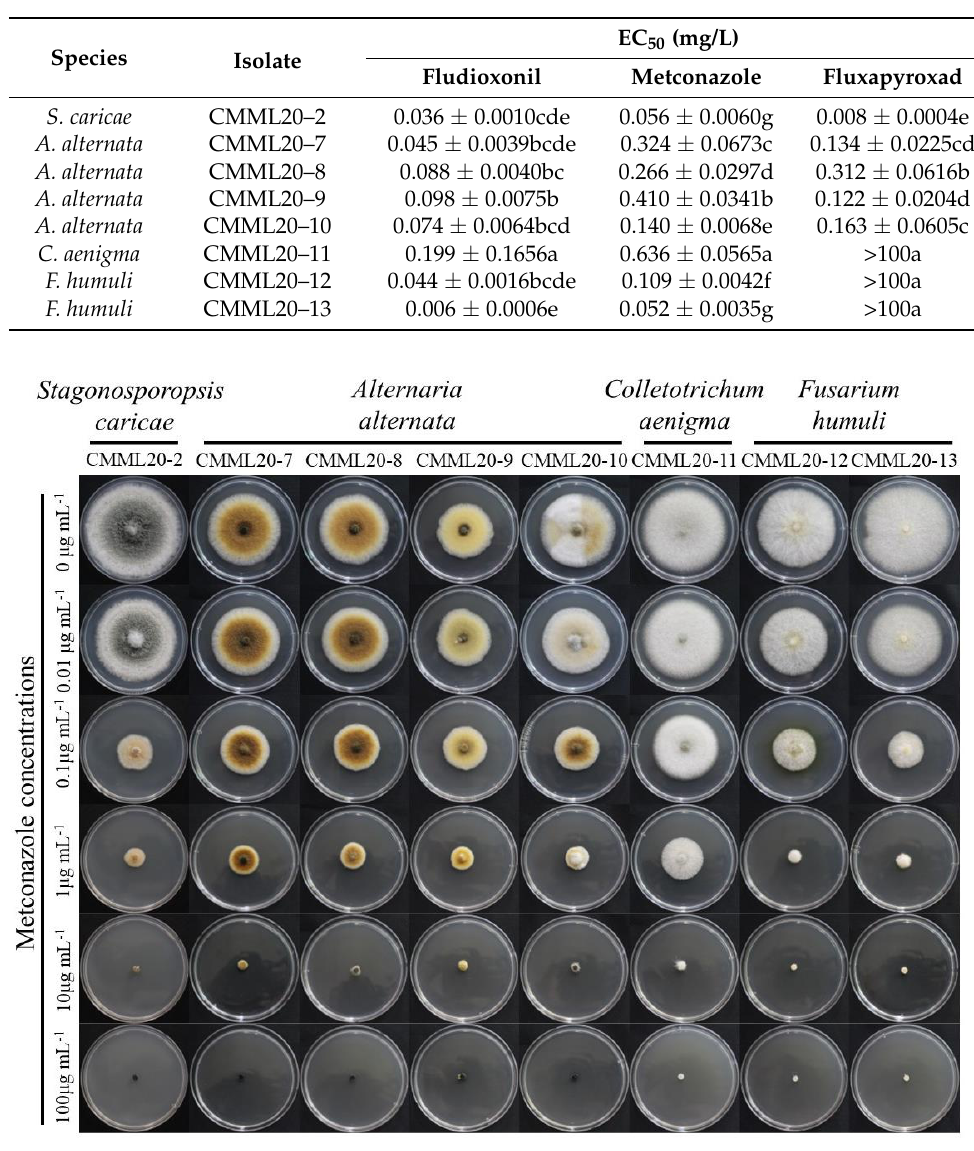
Figure 8. Anterior view of colonies of all fungal isolates on non-supplemented PDA and supple- mented with 0.01, 0.1, 1, 10, or 100 µ g mL − 1 of